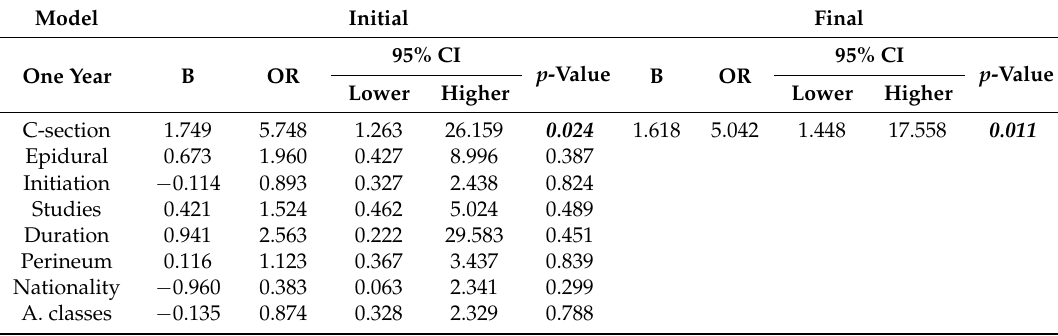
Table 5. Binary regression logistic model, predictors of childbirth experience at one year after birth ( n =